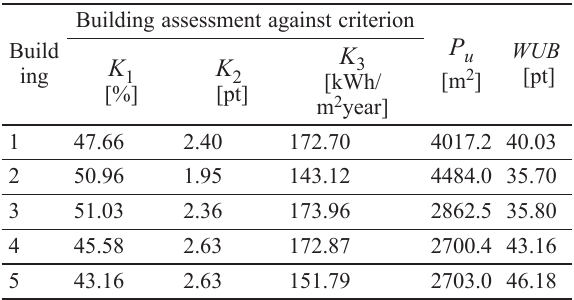
table 2. WUB calculated based on input data for 5 buildings building assessment against criterion build ing